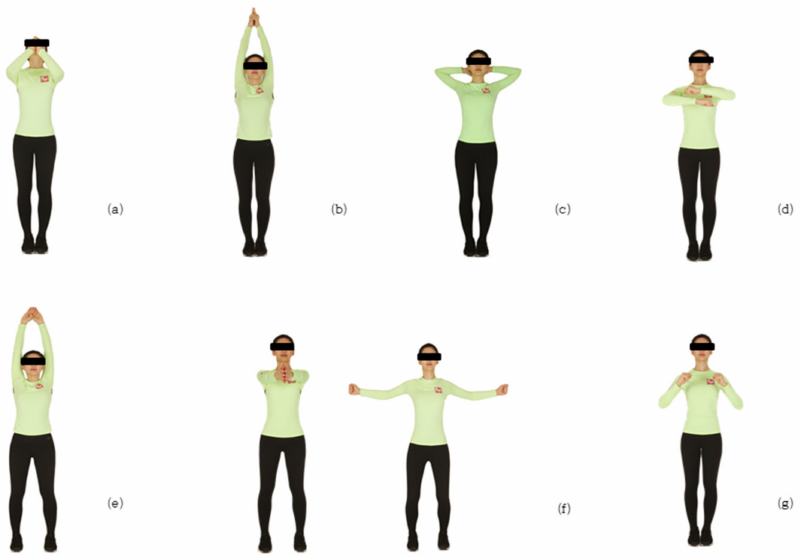
Figure 4. Exercises performed: ( a ) walking with the chin; ( b ) walking while praying; ( c ) walking while stretching shoulders; ( d ) walking while turning the wrist; ( e ) erector spinal muscle; ( f ) stretching the chest; and ( g ) jjamjjam